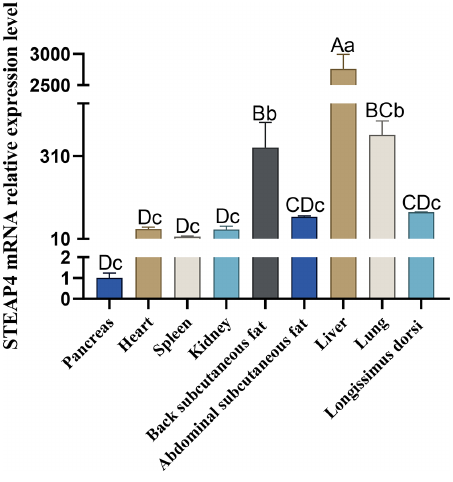
Figure 4. Distribution of STEAP4 in different tissues of goats.